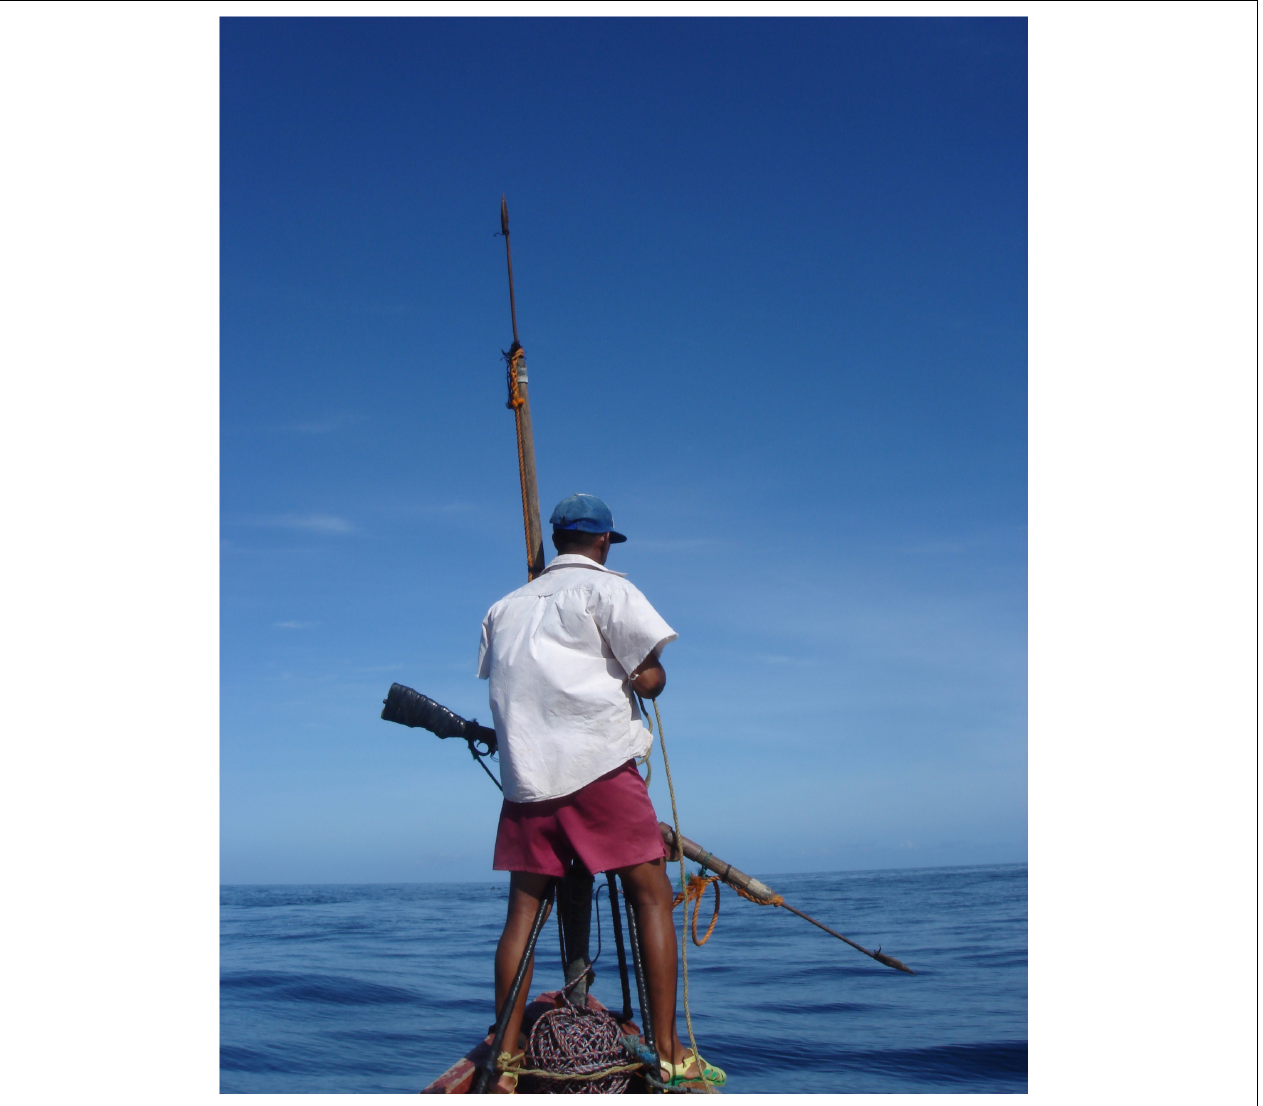
FIGURE 6 | A Barrouallie-based whaler standing in the bow of a whaling boat. Visible are both types of harpoons used: the two-meter long hand-thrown harpoon, which the whaler holds nearly vertical in this image, and the meter-long gun-fired harpoon, which points downward and is loaded in the gun mounted at the bow. Photograph by Russell